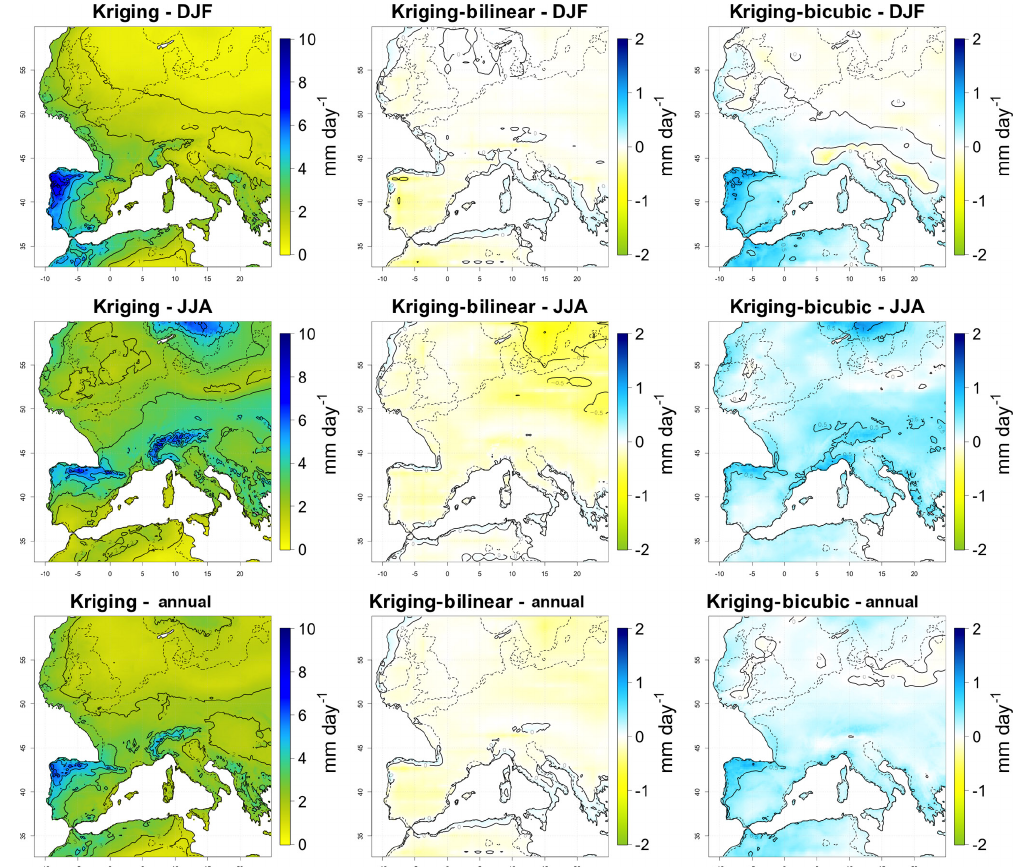
Figure 7. Mean distributions of downscaled daily precipitation over western Europe during the LGM for winter (December, January, Febru- ary), summer (June, July, August) and the whole year, computed over 50 years for the kriging interpolation technique, and difference between the kriging and the other two techniques. Downscaling was performed for each month independently, but results are combined into seasons to summarise the